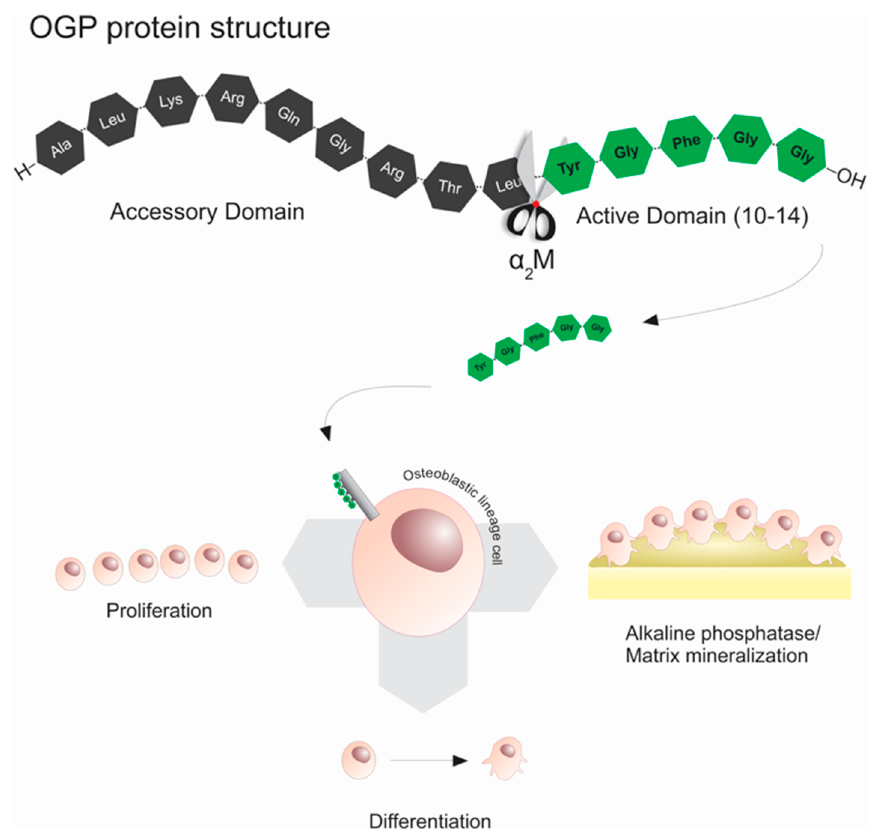
Figure 1. Schematic illustration of the structures of osteogenic growth peptide (OGP) and OGP(10–14) peptides and the interaction of the active domain protein with the osteoblastic lineage cells resulting in increased proliferation, differentiation, alkaline phosphatase activity and matrix mineralization.